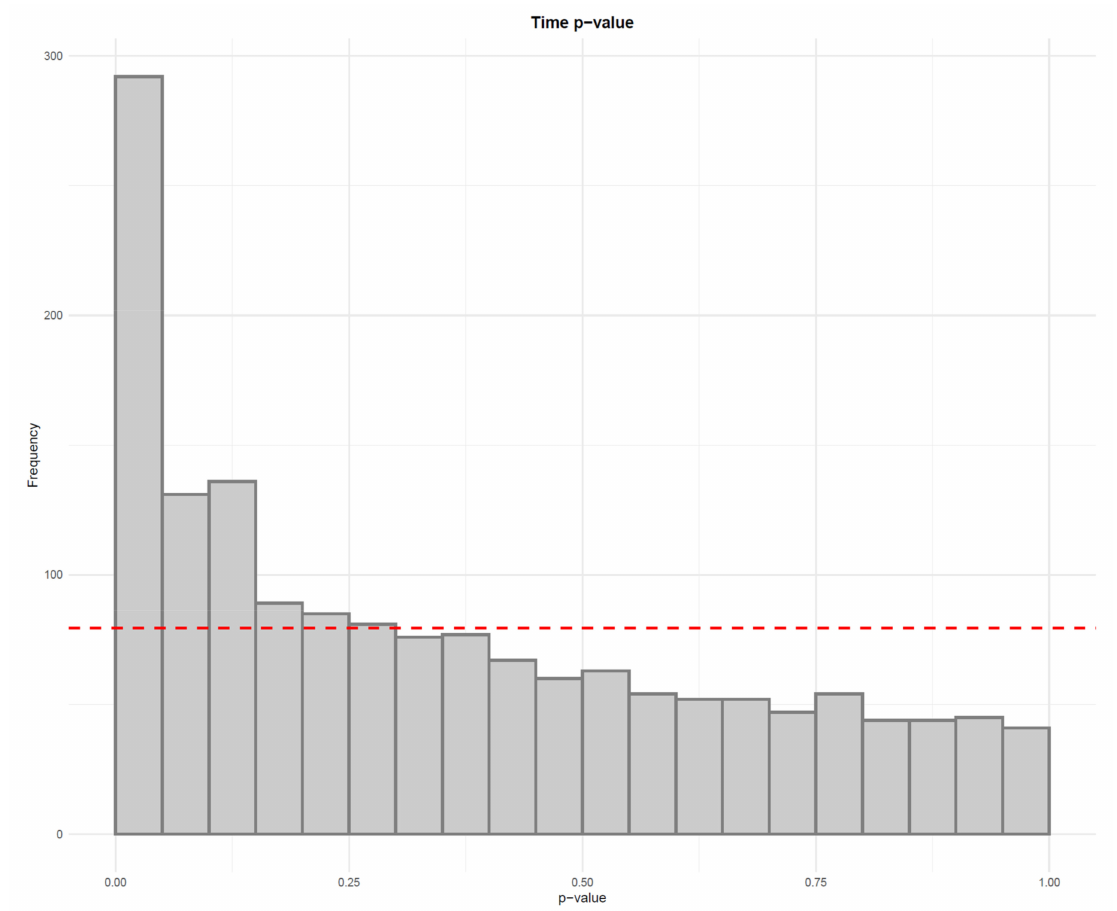
Figure 21. The distribution of p -values from linear models testing the di ff erence in feature abundance between two time points. Since the distribution clearly deviates from the uniform distribution depicted by the red line, it can be argued that there is a true di ff erence between the two time points. 79. Visualize the results of feature-wise tests in a volcano plot. Volcano plots are scatter plots with p -values on the y axis and e ff ect size (such as fold change) on the x-axis. Add a horizontal line representing the significance threshold for FDR-adjusted q-values. To co-visualize multivariate results, the features can be colored by their relevance score in the multivariate prediction (Figure